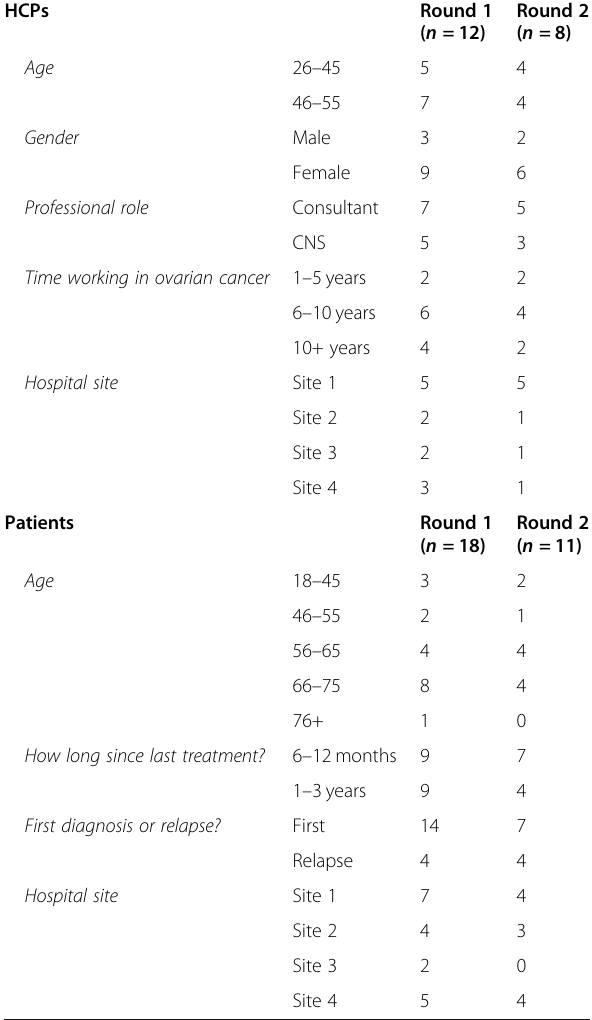
Table 1 Demographic details of the Delphi participants in each